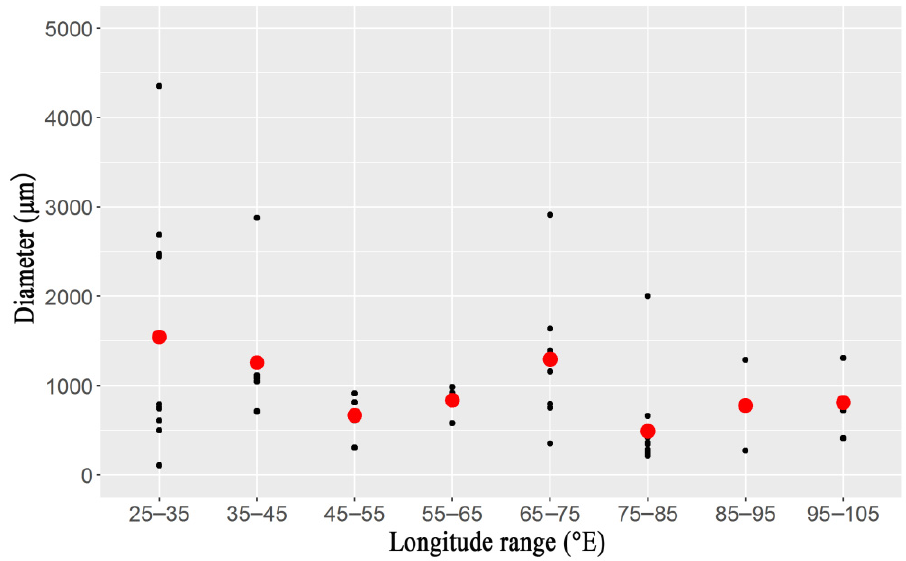
Figure 6. Particle size distribution characteristics of microplastics. (Red dot “ · ” is the average size of all microplastics. Black dot “ · ” is the size of each microplastic).